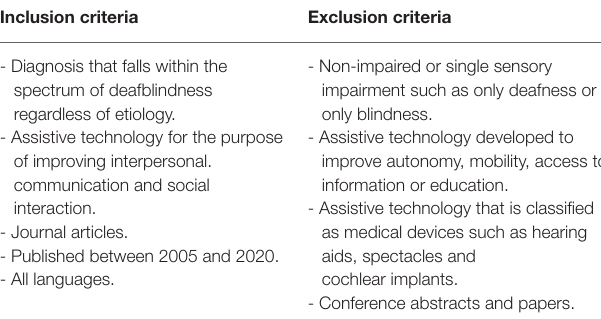
TABLE 1 | Inclusion and exclusion